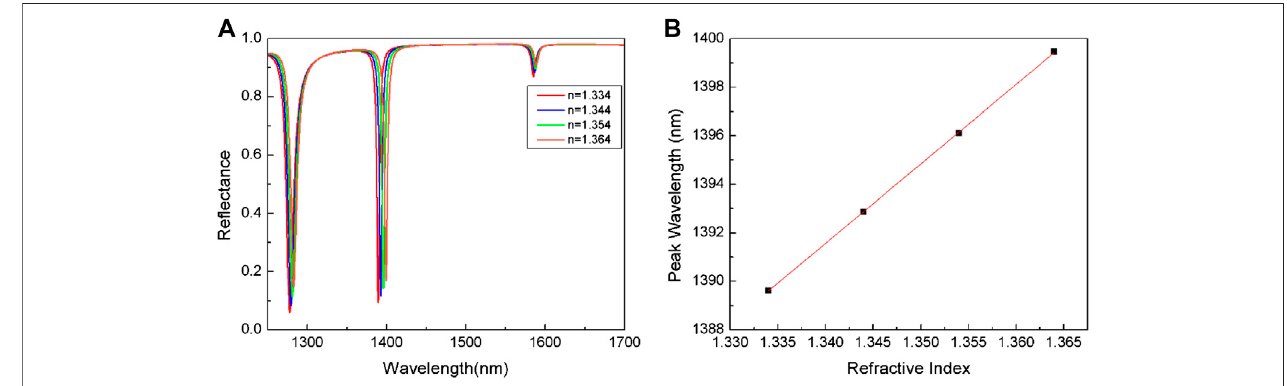
FIGURE 10 | (A,C) Re fl ectance spectra and (B,D) FOM* values of 1310 nm and 1550 nm structures with air and ethanol solution as medium.